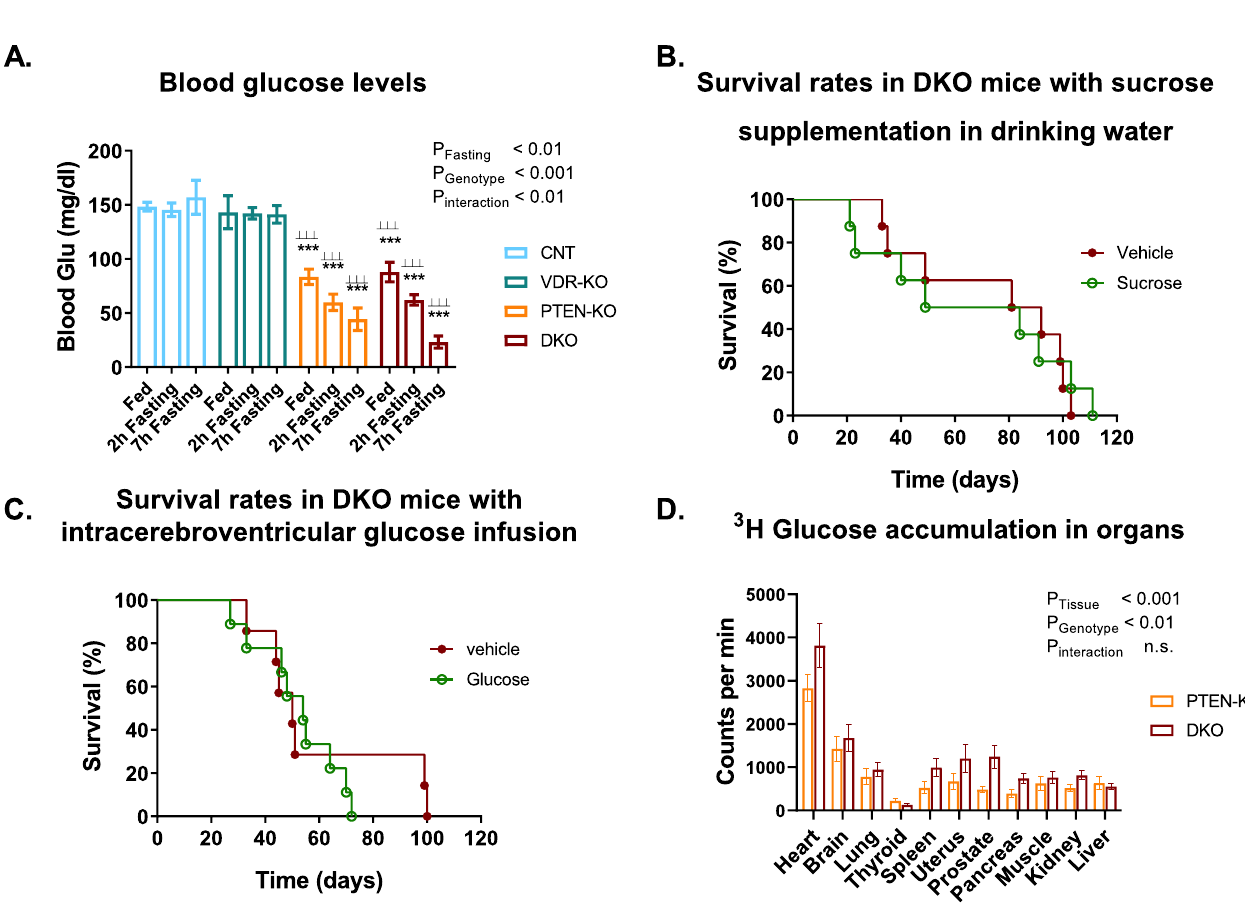
Figure 2. Administration of glucose did not increase survival in DKO. ( A ) Blood glucose levels in fed and fasting states. ( B ) Sucrose supplementation in drinking water or ( C ) intracerebroventricular infusion of glucose did not extend DKO survival, Long-Rank test p = 0.91 and 0.57 respectively. ( D ) Tissue glucose accumulation in PTEN-KO and DKO mice. 3 H-Glucose radioactivity was measured in 10 mg of different tissues. Data are represented as mean ± SEM. *** p < 0.001 vs. CNT; ⊥⊥⊥ p < 0.001 vs. VDR-KO. CNT: Control. VDR-KO: Vitamin D receptor knockout. PTEN-KO: Phosphatase and tensin homolog knockout. DKO: Double knockout. Table 2. Glucose and pyruvate tests.